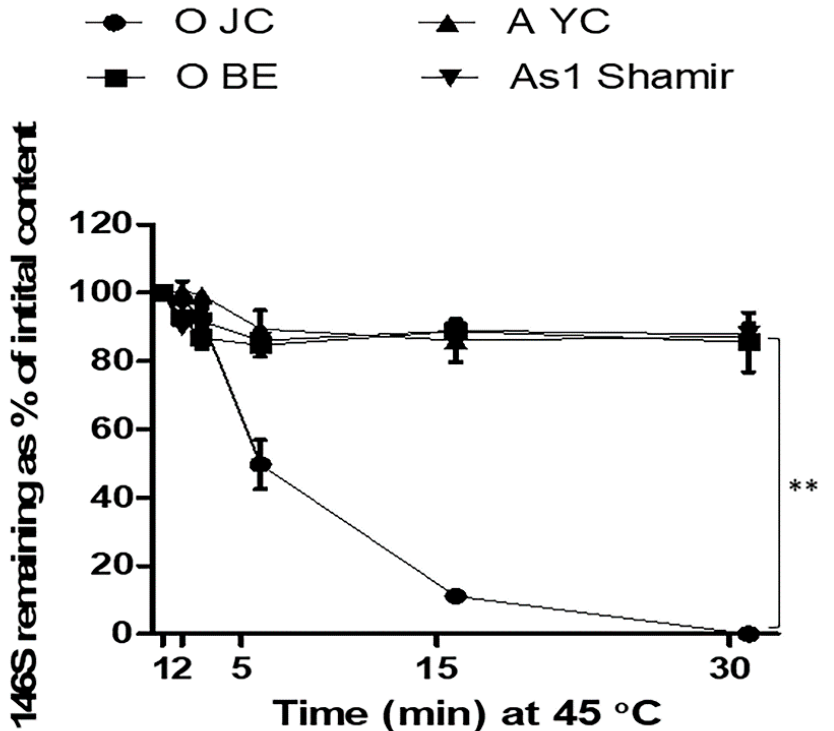
Figure 1. Characteristic thermal instability of foot-and-mouth disease virus (FMDV) O SKR/JC/2014. FMDV O SKR/JC/2014 (O JC), O SKR/BE/2017 (O BE), A SKR/YC/2017 (A YC), and Asia 1 Shamir/ISR/1989 (As 1 Shamir) were heated at 45 °C and their 146S antigen recovery (%) was calculated at each time point (1, 2, 5, 15, and 30 min) based on the antigen quantity measured by sucrose density gradient fractionation. **, p < 0.01.